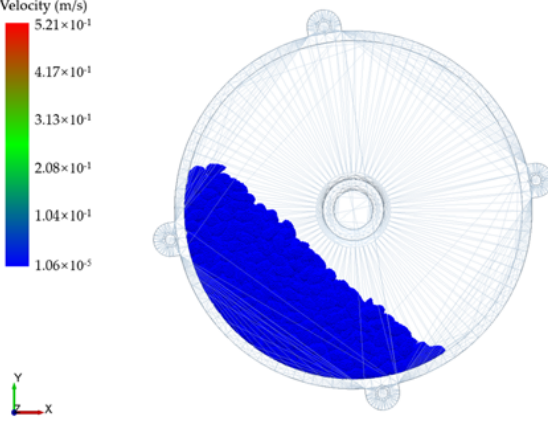
Figure 10. Cotton seeds stacking state.